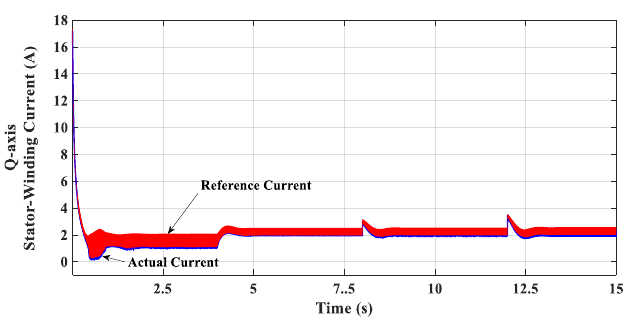
Figure 13. Stator current q-axis component.